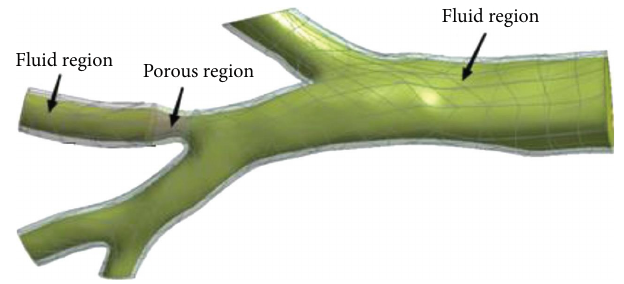
F IGURE 1: Pulmonary artery stenosis model.